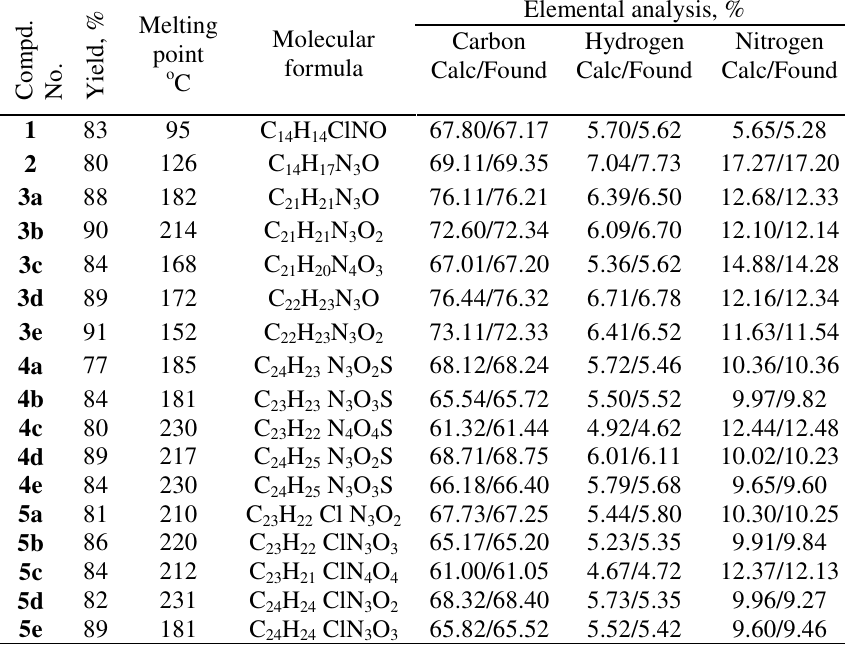
Table 1. Analytical data of (4a-e) and (5a-e). Elemental analysis, %